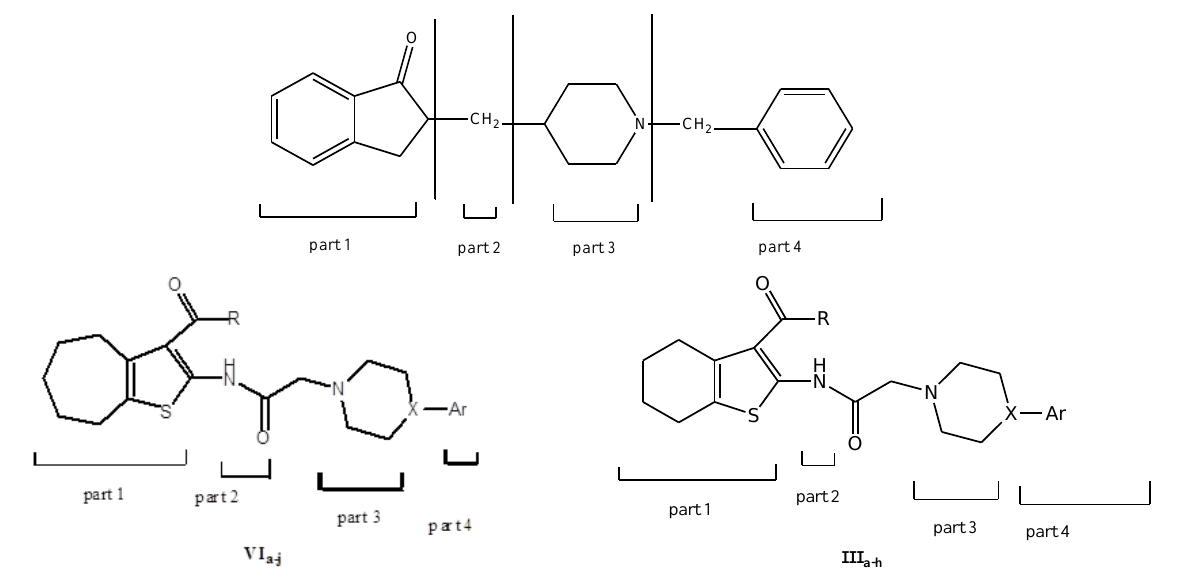
Figure 2. Design strategy of the newly synthesized